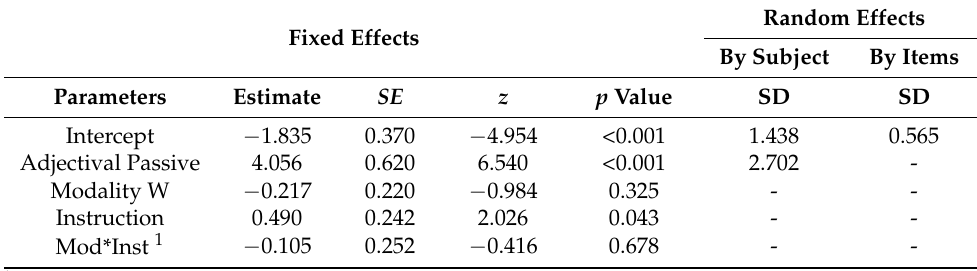
Table 9. Parameter estimates for L2 learners’ comprehension of passives by proficiency.